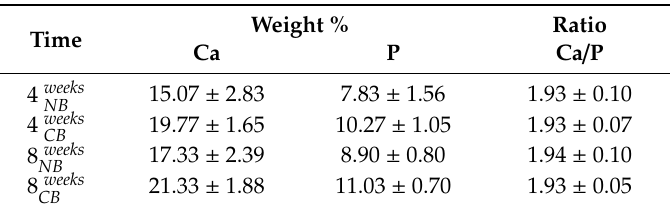
Table 1. Results of the quantitative analysis of the newly formed bone around implants and cortical bone, after four and eight weeks. Table adapted with permission from